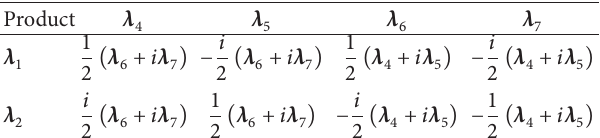
Table 5: Multiplication table of Gell-Mann matrices { 𝜆 1 , 𝜆 2 }{ 𝜆 4 , 𝜆 5 , , 𝜆 } (left times top). 𝜆 6 7